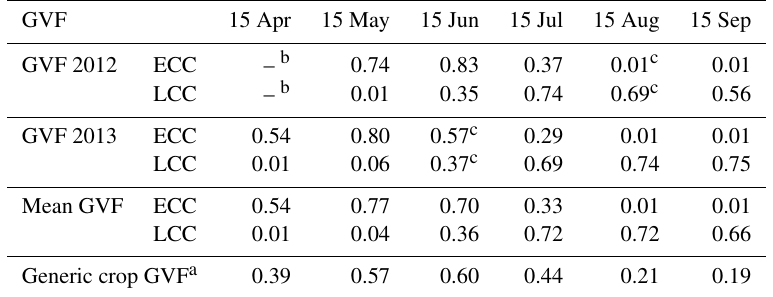
Rainfall and snowfall Lower boundary of soil temperature Snow/soil temperature time scheme Table 2. GVF dynamics of early-covering crops (ECC) and late-covering crops (LCC) in 2012 and 2013 in the Kraichgau region, southwest Germany, as well as the GVF dynamics of the generic